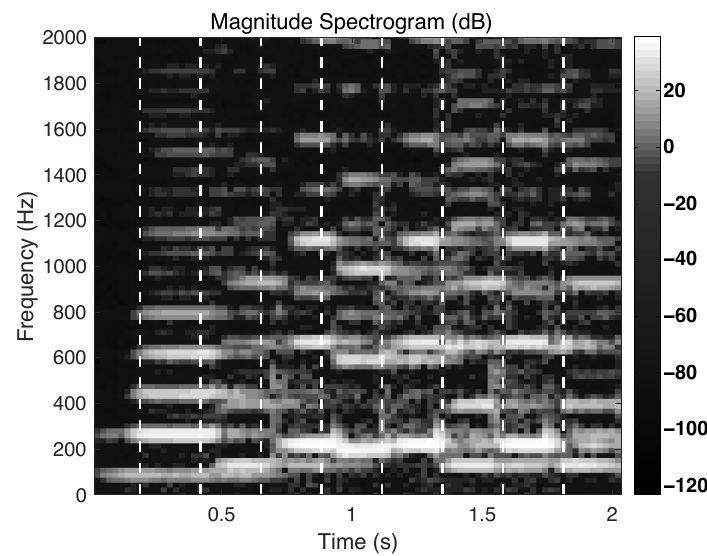
Figure 1. Spectrogram of a selection from Cello Suite No. 1 Prelude by J. S. Bach (BWV 1007) consisting of the notes F2, C3, A3, and G3. Vertical dashed lines indicate the starting points of every tenth frame.